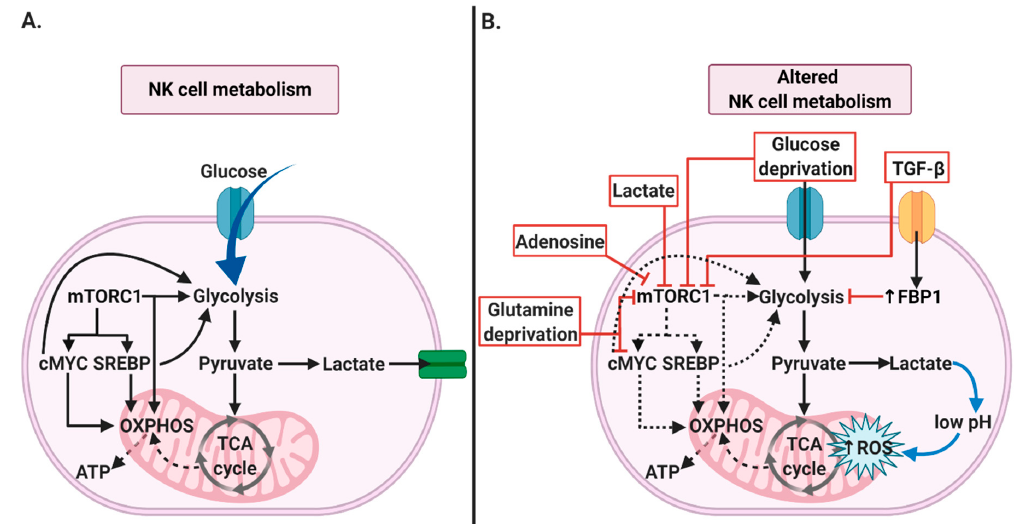
Figure 3. NK cell metabolism. ( A ) Key regulators of NK cells metabolism. Activated NK cells are characterized by increased glucose uptake and OXPHOS. mTORC1 is the key factor, controlling NK cell metabolism by upregulation of NK cells’ glycolysis and OXPHOS. mTORC1 is also involved in activation of cMYC and SREBP, which may further modulate glycolysis and OXPHOS. ( B ) Mechanisms disrupting NK cell metabolism in cancer. Many factors within the tumor microenvironment, can directly impact rates of glycolysis and OXPHOS by interfering with mTORC1, cMYC, or FBP1 activity. Moreover, mitochondrial dysfunction through ROS accumulation can be induced by intracellular lactate